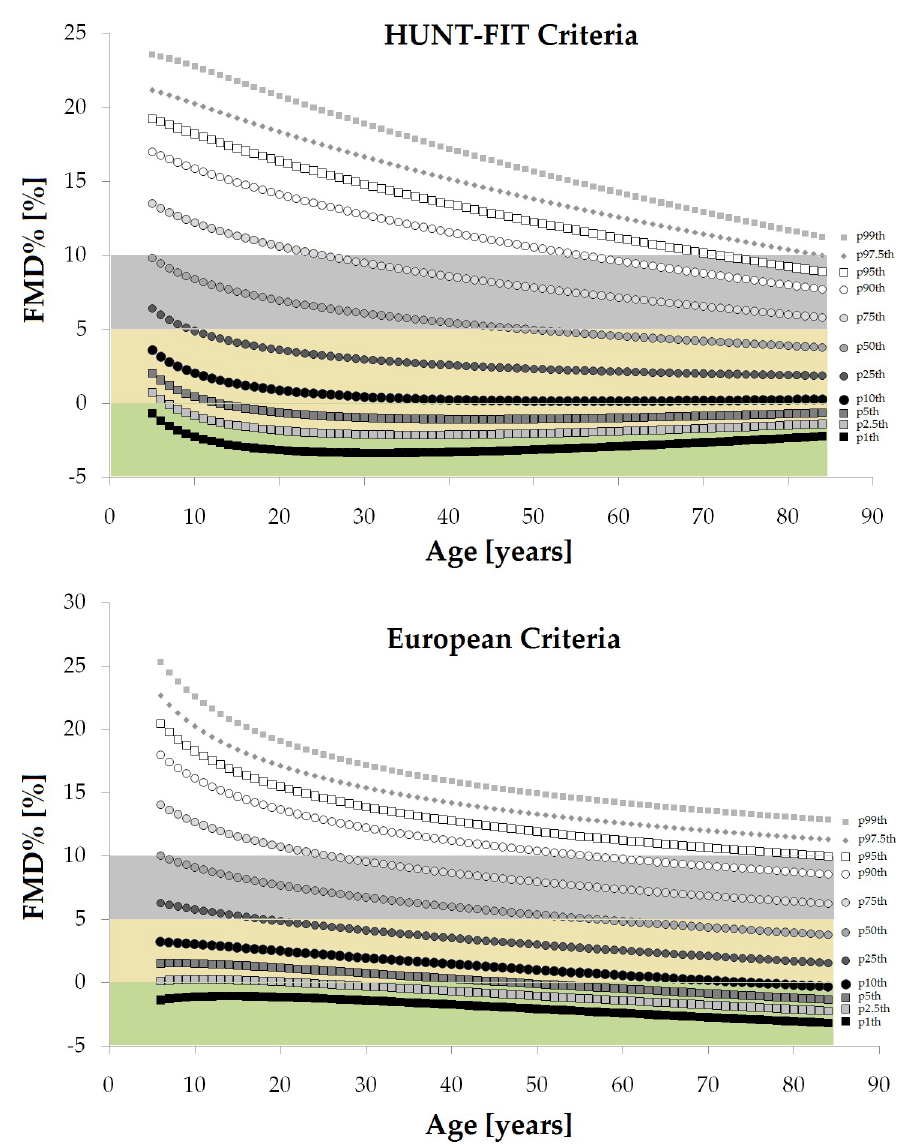
Fig 10. Comparative age-related profiles for FMD% considering different cut-off values to define ´low FMD%´ (based on previous reports). (i) � 0.0% [13], (ii) � 5.0% [57–59]and (iii) � 10% [60].